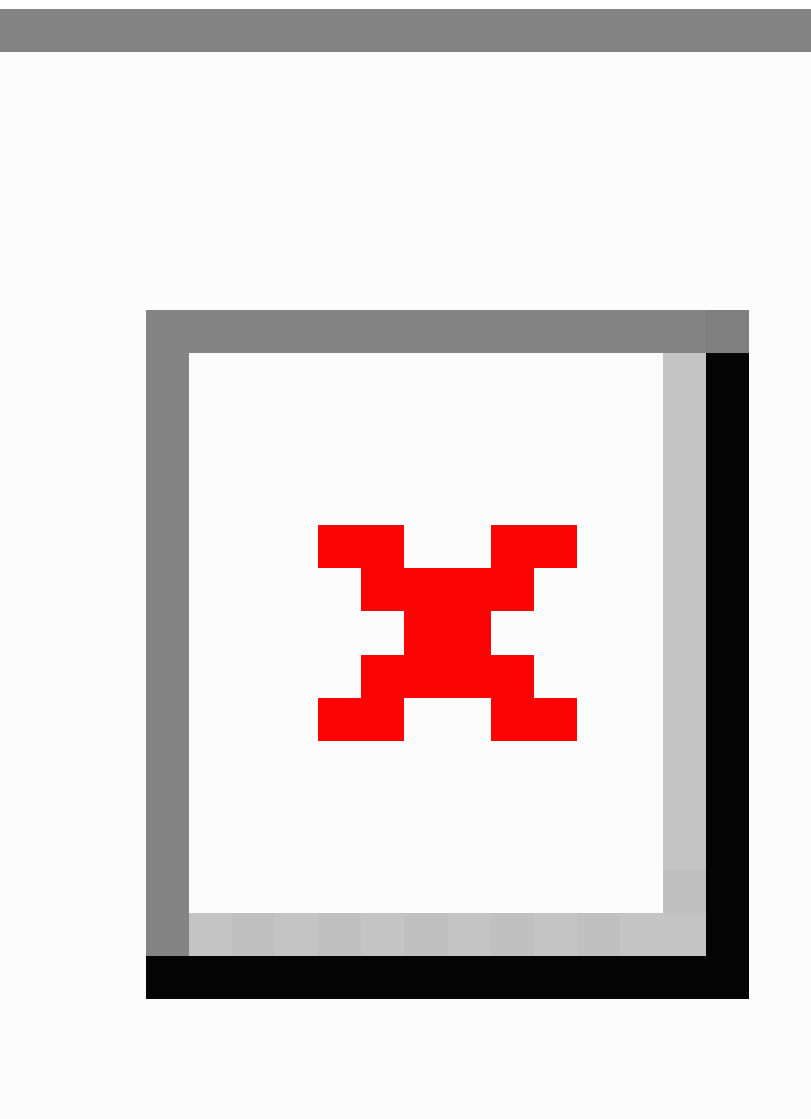
Figure 1. Number of key population hotspots per 100,000 population by local government area in 7 US President’s Emergency Plan for AIDS Relief Priority States in